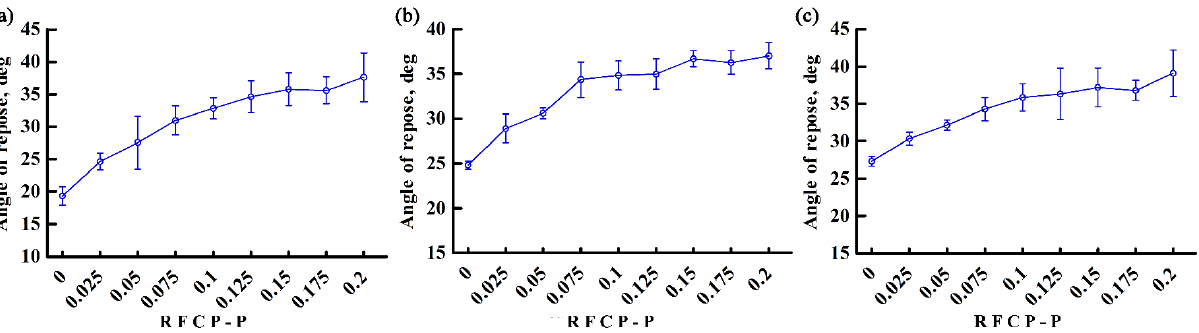
Figure 11. The relationship between angle of repose and RFCP-P for ( a ) SN42, ( b ) JD17, and ( c ) ZD39.